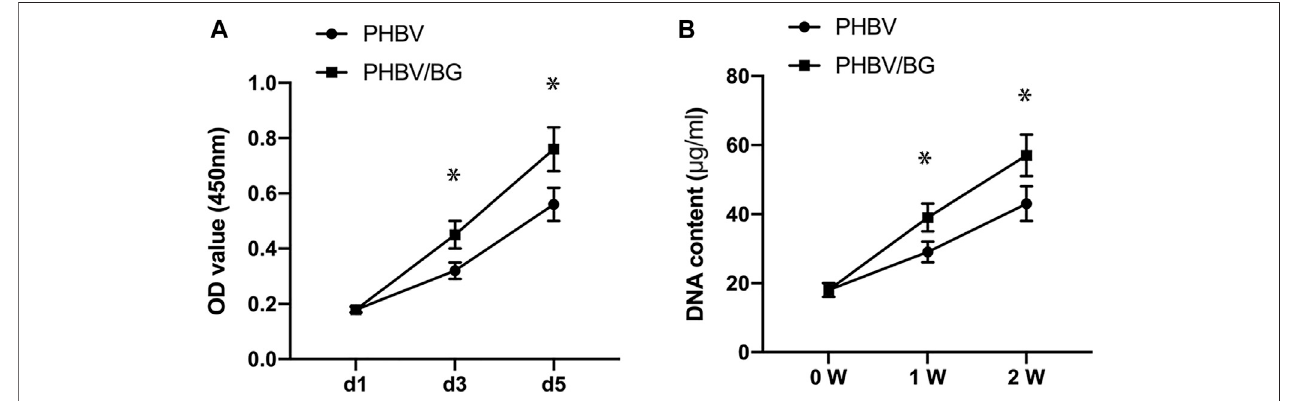
FIGURE 4 | Cell Proliferation. There was an obvious difference in the cellular proliferation between the CPC – PHBV construct and CPC – PHBV/10%Bioglass construct ( p < 0.05) (A) . The DNA content of the CPC – PHBV/10%Bioglass construct is higher than that of the CPC – PHBV construct ( p < 0.05) (B)